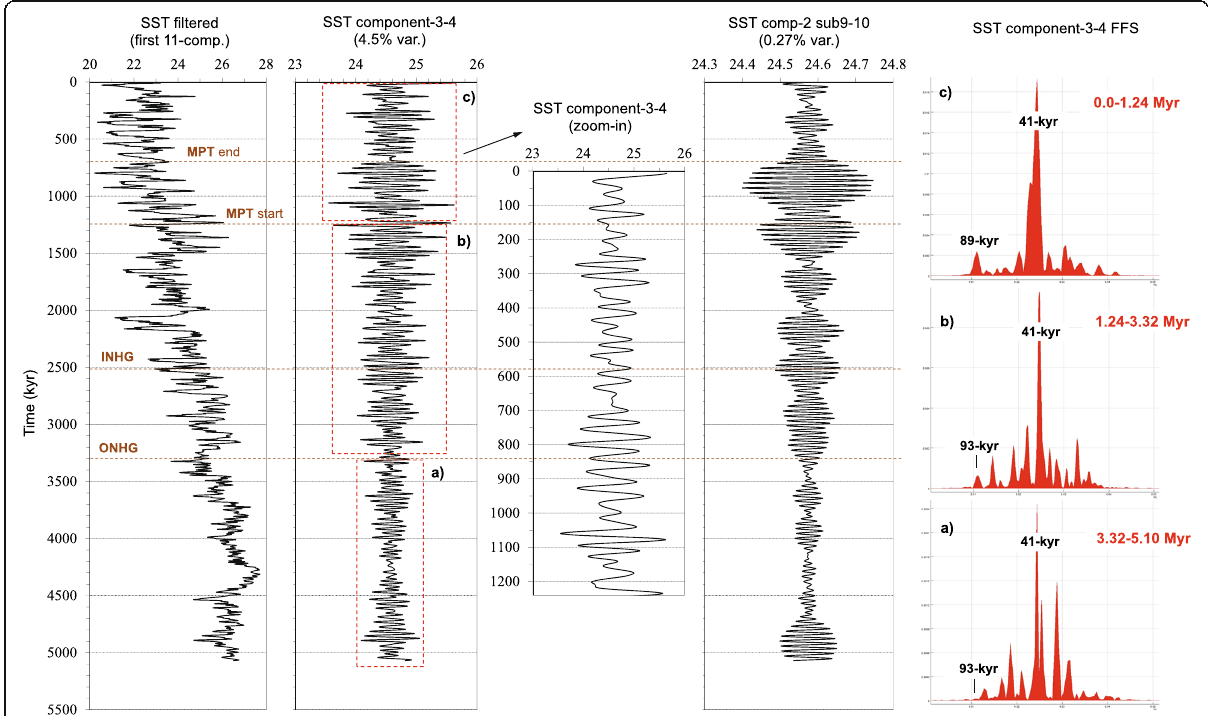
Fig. 8 Time-series panel of the ODP Site 846 SST obliquity ’ s component-3-4 (4.5% var.) and component-2 subcomp-9-10 (0.27% var.). Fourier frequency spectrum of comp-3-4 by three time intervals highlighted by red labeled boxes. The spectrum is always dominated by obliquity 41-kyr power. Note a clear increase in the average 41-kyr amplitude and power towards the beginning of the MPT (box 8a and 8b), followed by a clear decrease in amplitude after the beginning of the MPT (box 8c and comp-2 subcomp-9-10). The envelope of two to three obliquity cycles in a weak eccentricity ~93-kyr framework after the beginning of the MPT is less evident (box 8c and magnified time series to the right). FFS scale power increasing from a to b and was constant from b to c . x -axis scale variable (°C). Timescale in